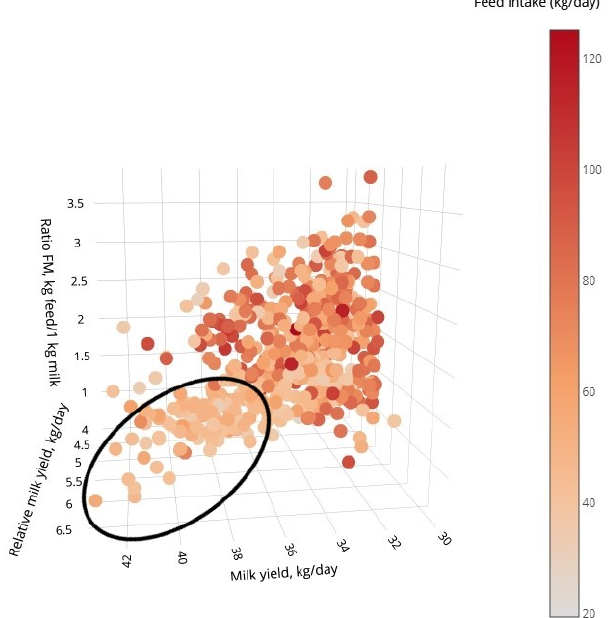
Figure 1. Association of milk yield, relative milk yield (milk yield per 100 kg of body weight), and FCR (feed conversion efficiency per 1 kg milk) in the range of 31 to 209 days in milk and milk yield ≥ 30 kg/day; milk yield: mean ± SD = 34.5 ± 3.1 kg/d, relative milk yield: mean ± SD = 5.14 ± 0.55 kg/d, FCR: mean ± SD = 1.80 ± 0.62 kg feed/1 kg milk; the black circle includes the highest yielding and feed efficient cows.